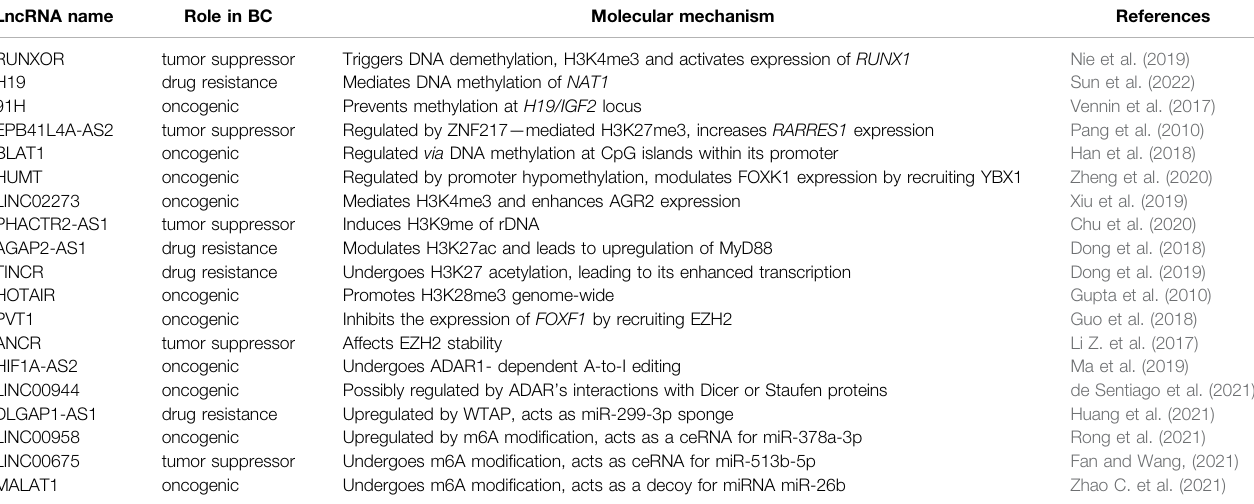
TABLE 1 | A summary for lncRNAs with roles in breast cancer epigenetics and epitranscriptomics.